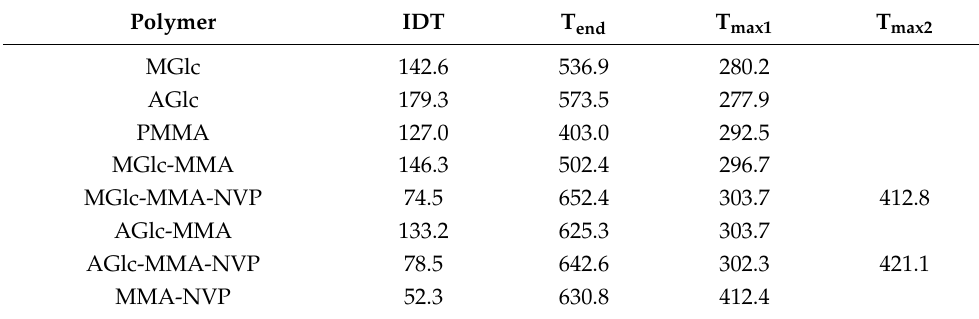
Table 4. Thermal properties ( ◦ C) of the obtained